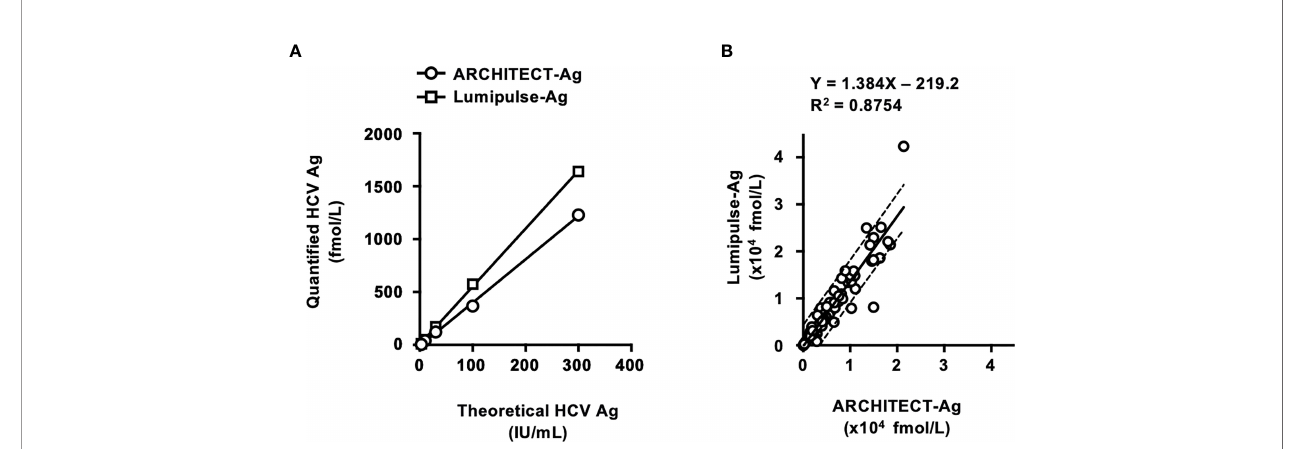
FIGURE 3 | Evaluation of HCV Ag quanti fi cation kits using International Standards and a regional reference panel. (A) Quanti fi ed HCV Ag titers of serially diluted WHO International Standards. The WHO International Standard for HCV Ag (IS-Ag) was serially diluted to 300, 100, 30, 10, 3, and 1 IU/mL and quanti fi ed by ARCHITECT-Ag (circles) and Lumipulse-Ag (squares). (B) Correlations of HCV core Ag titers of the specimens in the HCV reference panel quanti fi ed by ARCHITECT- Ag and Lumipulse-Ag. Dashed lines indicate the 95% con fi dence intervals for the regression line. The correlation equation and the R 2 value are indicated at the top of the